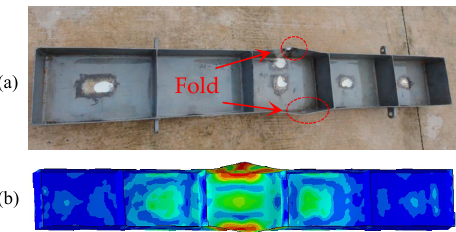
Figure 5. Fold shape of side plates: ( a ) experimental photo [23]; ( b ) calculated cloud